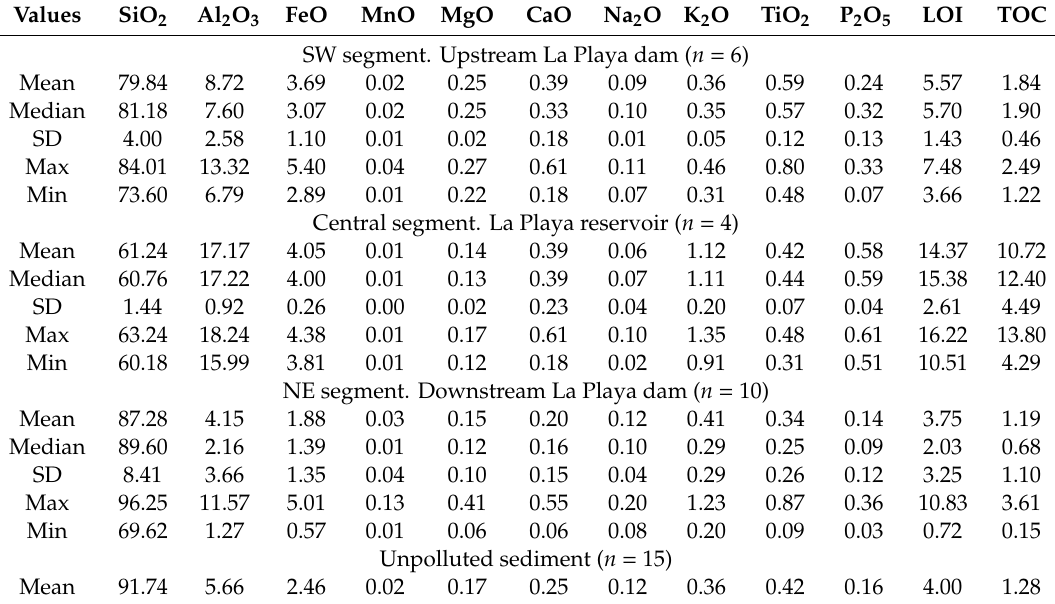
Table 1. Major element sediment compositions determined by XRF and content in total organic carbon (TOC) (in weight percent). SD: Standard Deviation; Max: Maximum; Min: Minimum. Complete dataset is available in the Supplementary Materials (Table